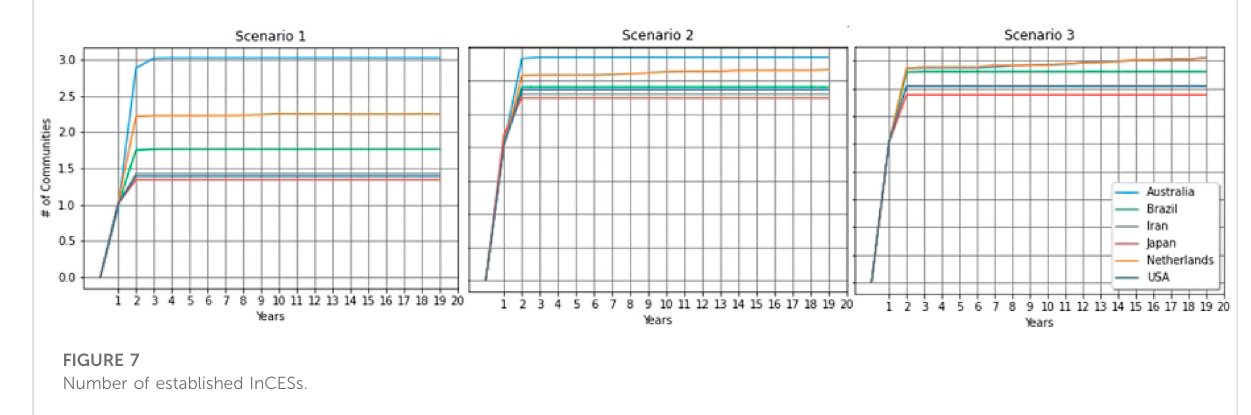
FIGURE 7 Number of established InCESs.